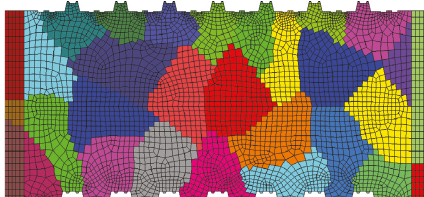
Figure 2: Decomposition of the finite element mesh at the macro- level.